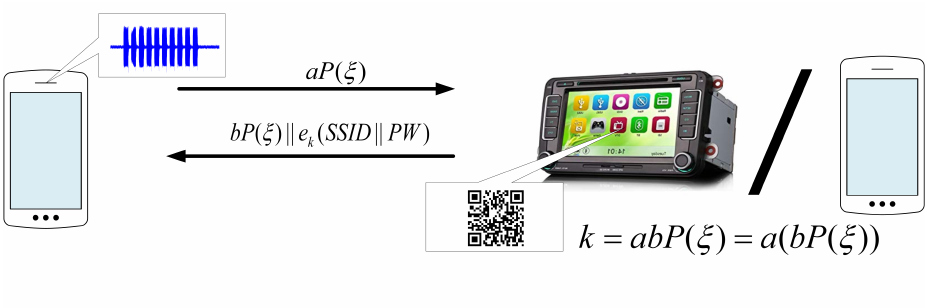
Figure 1. The addressed setting: key exchange between a phone and a head unit (or another